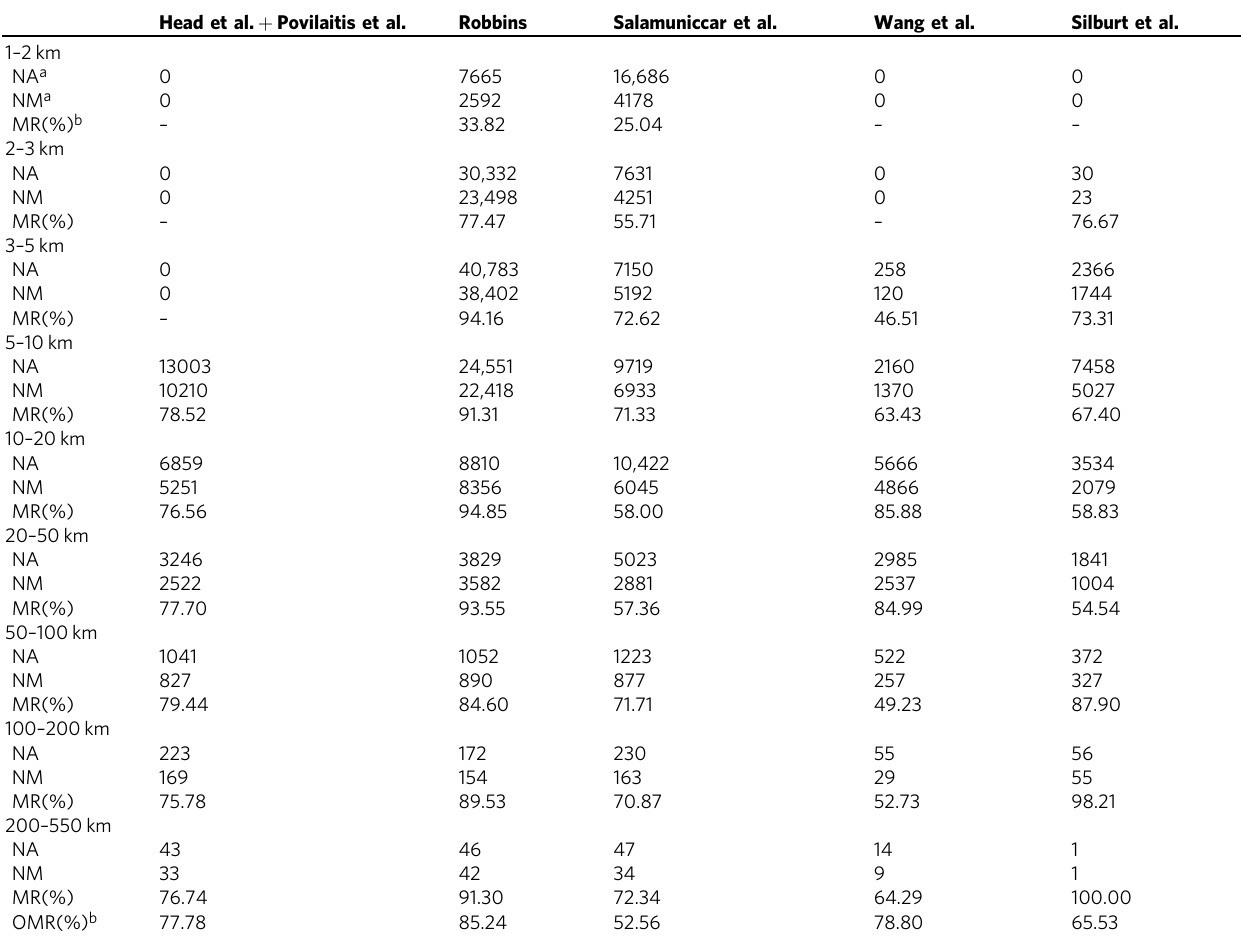
Table 1 Comparison between the identi fi ed craters and existing lunar crater databases in terms of number and percentage of matching craters for different diameter scales.